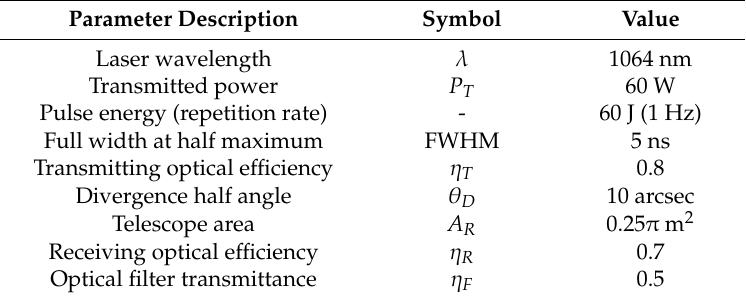
Table 1. Optical parameters of transmitter and